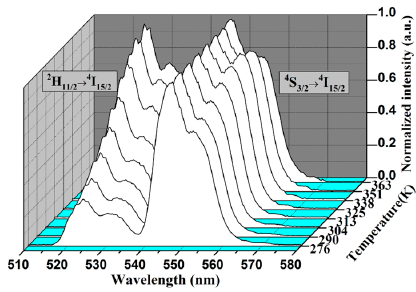
Figure 4. Effect of temperature on upconversion emissions in the Er 3+ /Yb 3+ doped TZNb glass.